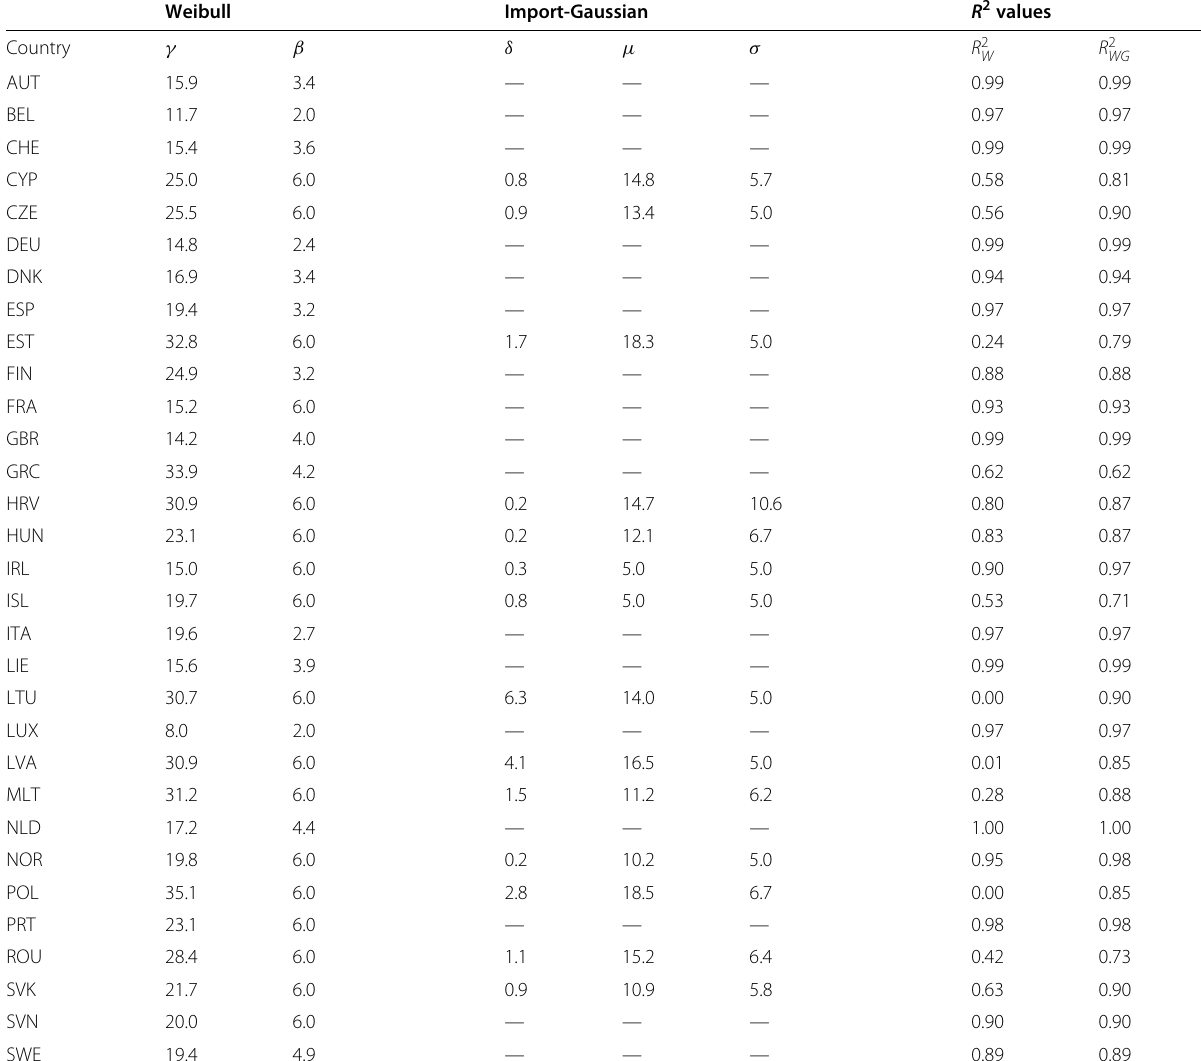
Table 1 Cumulative Survival Probability (CSP) fitting parameters